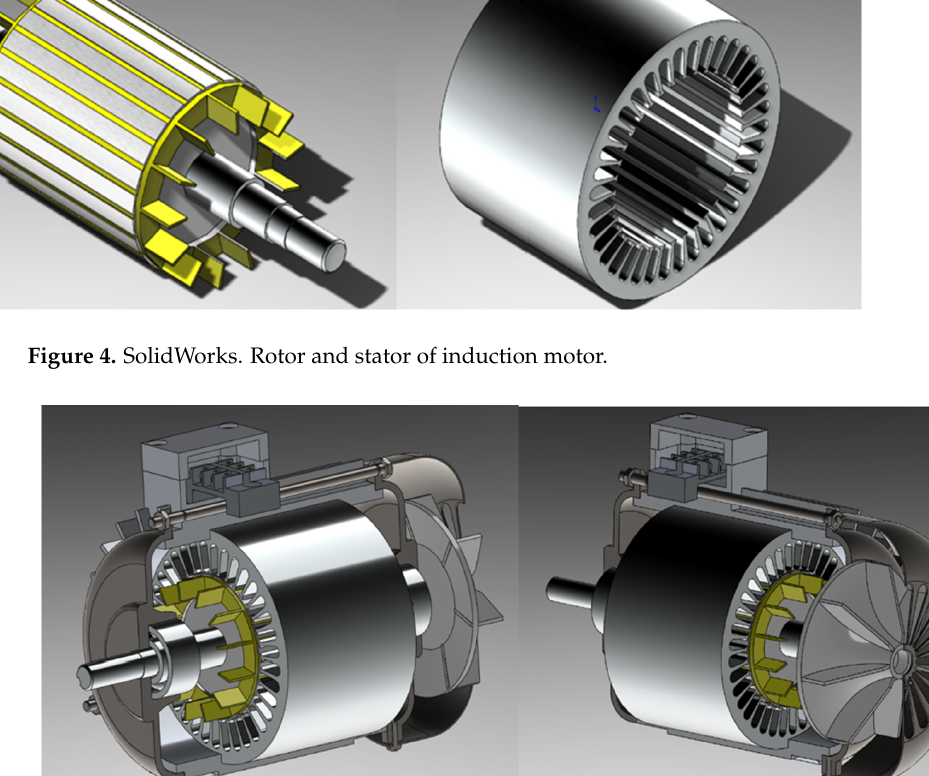
Figure 6. SolidWorks. 3D model of an induction motor AIR 63V2. In Ansys Electronic Suite—Maxwell RMxprt, the electrical parameters of an induc- tion motor (IM) can be calculated. Like any other motor, an IM is characterized by its power, supply voltage, current consumption, and connection type; however, many of the parameters listed in the motor data sheet are nominal without taking into account inaccu- racies or assumptions. The RMxprt program within the Ansys Electromagnetic Suite, a part of the Maxwell complex, can be used to calculate the electrical parameters of the IM AIR 63V2 motor. This calculation utilizes classical analytical theory of electrical machines and the equivalent magnetic circuit method. It takes into account various effects, such as the non-linearity of electrical steel, non-sinusoidal magnetic flux in the gap, and current displacement in mas- sive conductors. One of the advantages of this program is the ability to modify parameters during the entire calculation process, allowing for the comparison of different characteristics with different initial data to obtain the optimal values [29]. To handle more extensive calculations, the setup established in RMxprt can be trans- formed into a Maxwell model, which employs the finite element method (FEM) to pre- cisely evaluate static, harmonic electromagnetic and electric fields, as well as transients. The finite element method (FEM) is a numerical approach utilized to solve partial differential equations and integral equations that arise in a wide range of applied physics problems. It has proven to be an effective technique in the fields of solid mechanics, heat